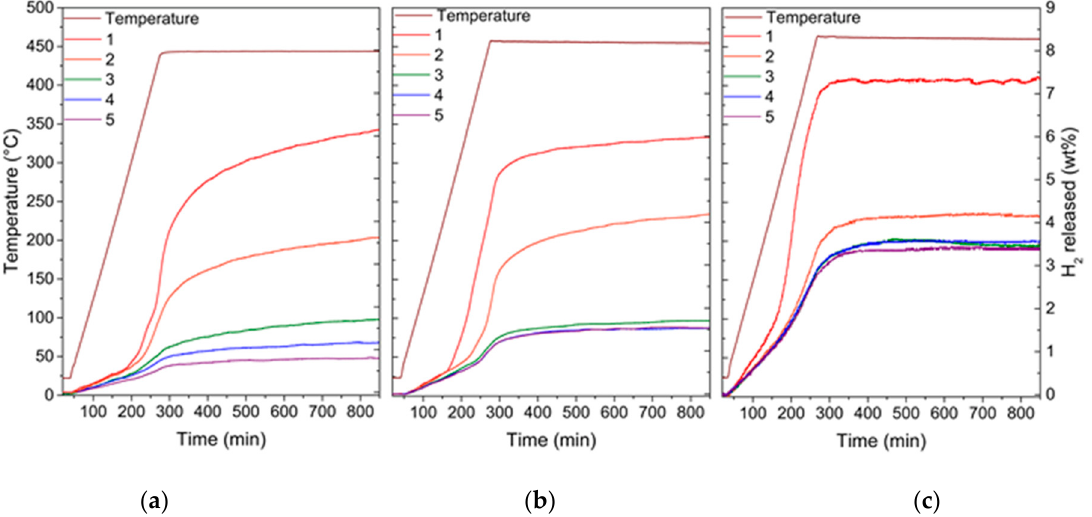
Figure 5. Kinetics and quantitative measurement of hydrogen release and uptake was investigated using a manometric method (Sieverts apparatus). From left to right: ( a ) LiNa, ( b ) LiNa/CD and ( c )